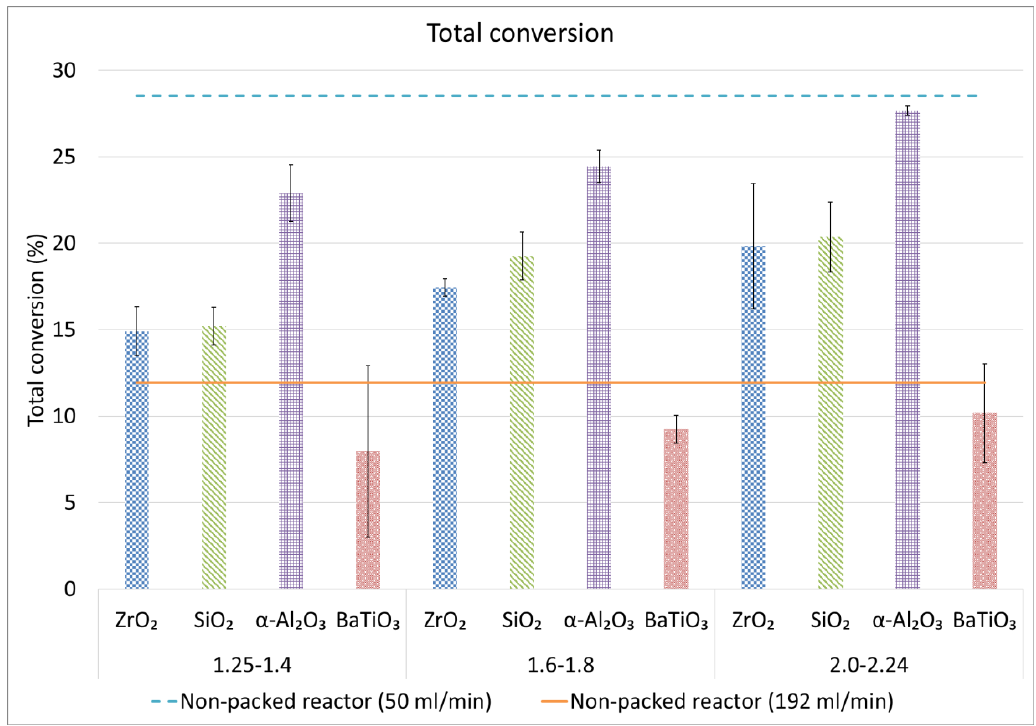
Figure 3. Total conversion for different sphere sizes and materials, compared to the results for the non-packed reactor, at the same flow rate (50 mL/min) and at the same residence time (5.52 s; flow rate of 192 mL/min).